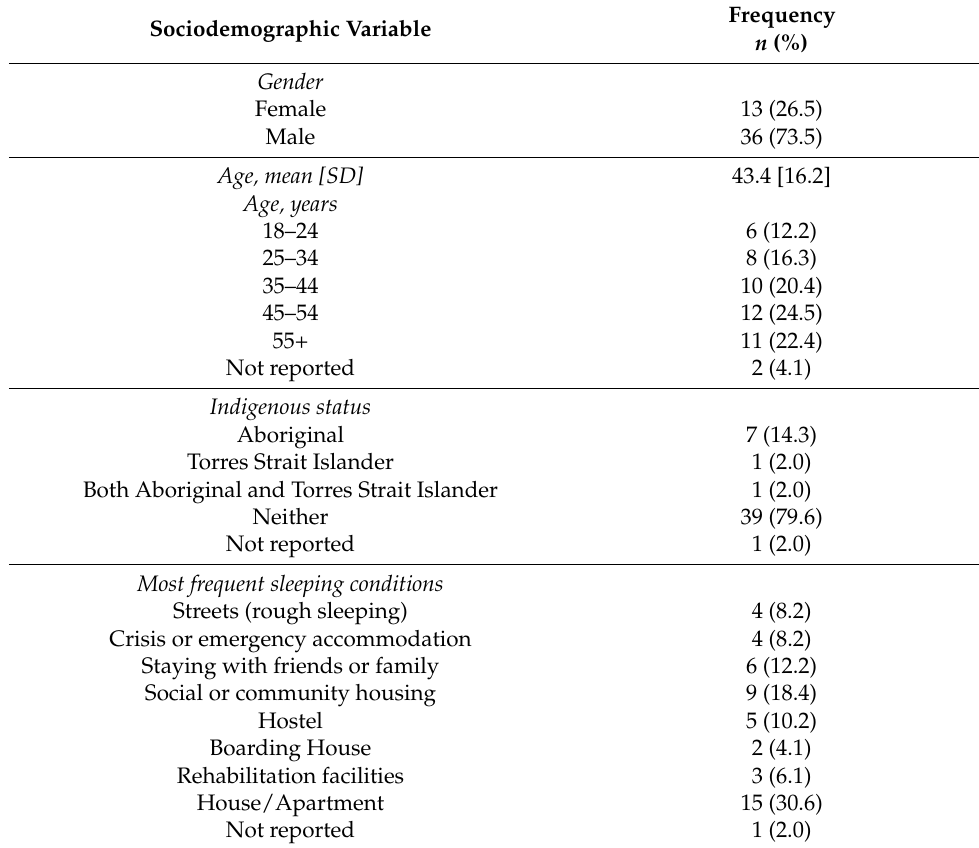
Table 2. Sociodemographic characteristics (N =